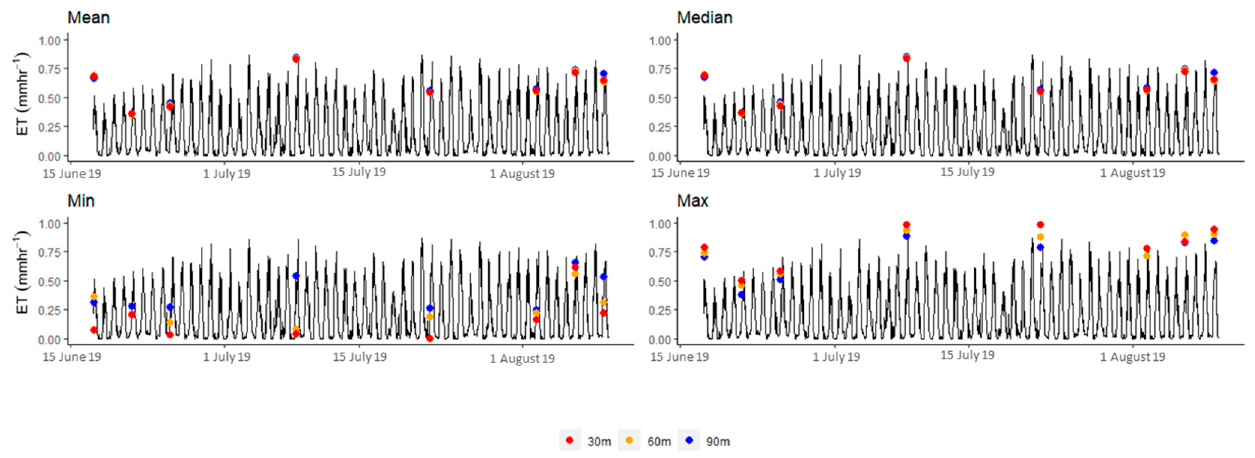
Figure 10. Timeseries of EC ET (black line, mm h − 1 ) compared to the instantaneous HRMET ET (points, mm h − 1 ) for different flight elevations.